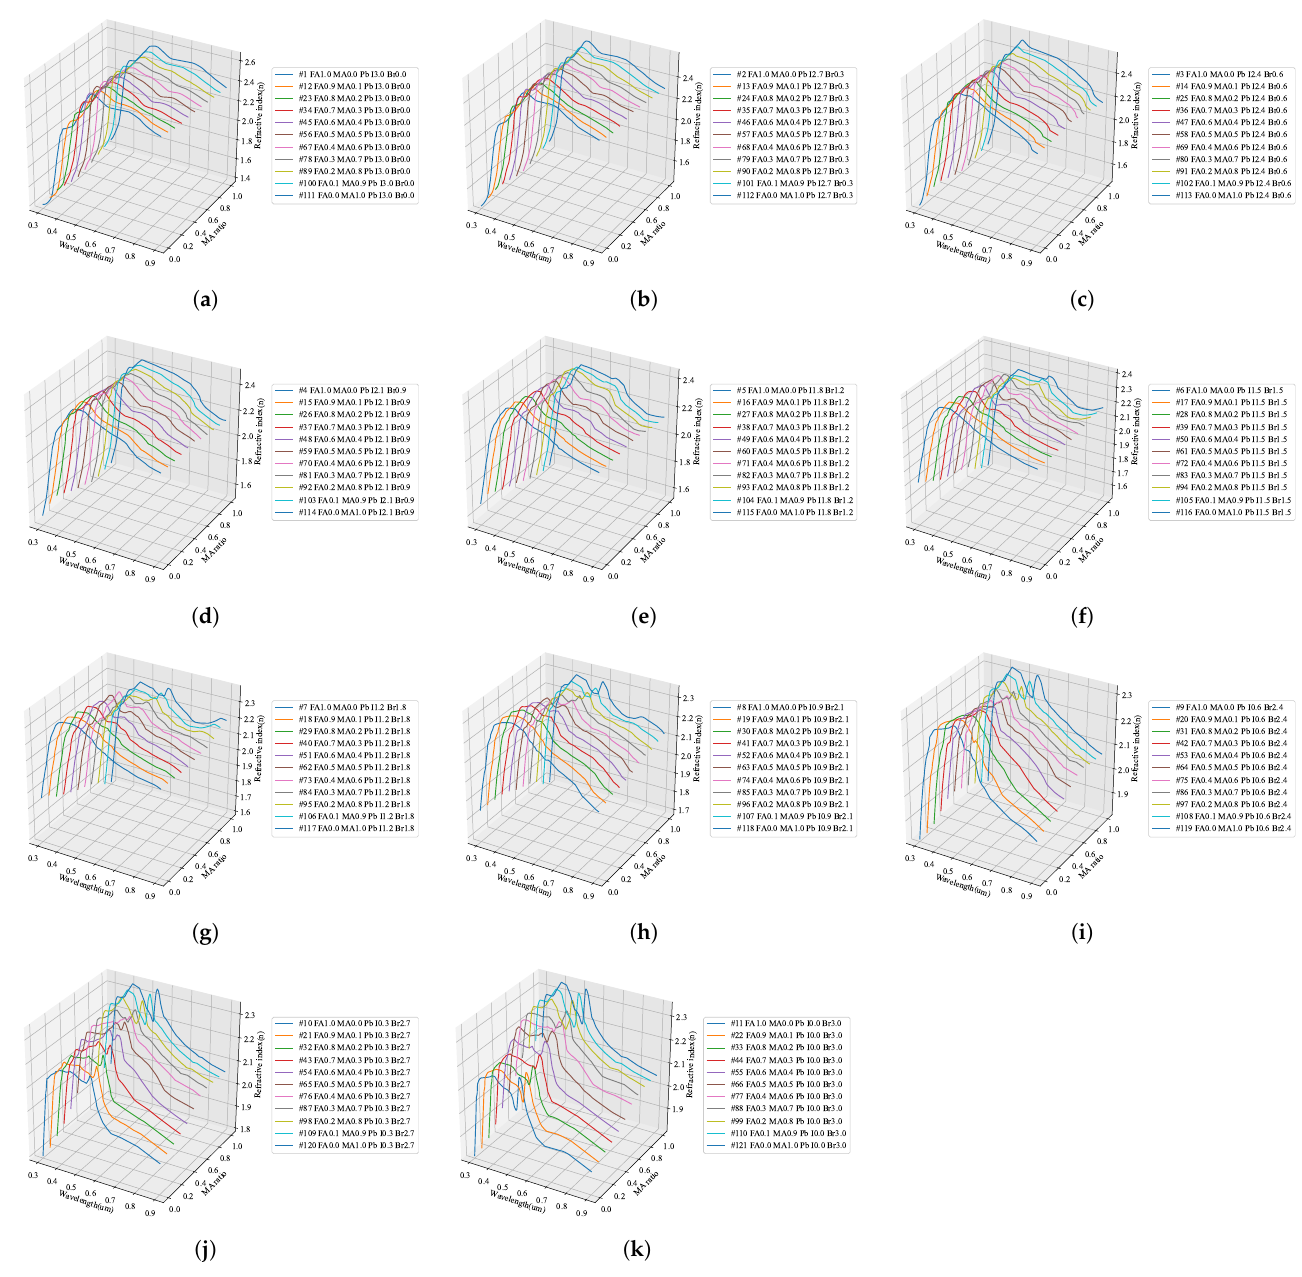
Figure 10. Prediction result of the refractive index spectrum pattern according to the stoichiometric ratio in the direction of increasing MA composition of quaternary perovskite using hyperregression analysis with artificial intelligence: ( a ) FA 1 x MA x PbI 3 Br 0 , ( b ) FA 1 x MA x PbI 2.7 Br 0.3 , ( c ) FA 1 x MA x PbI 2.4 Br 0.6 − − −